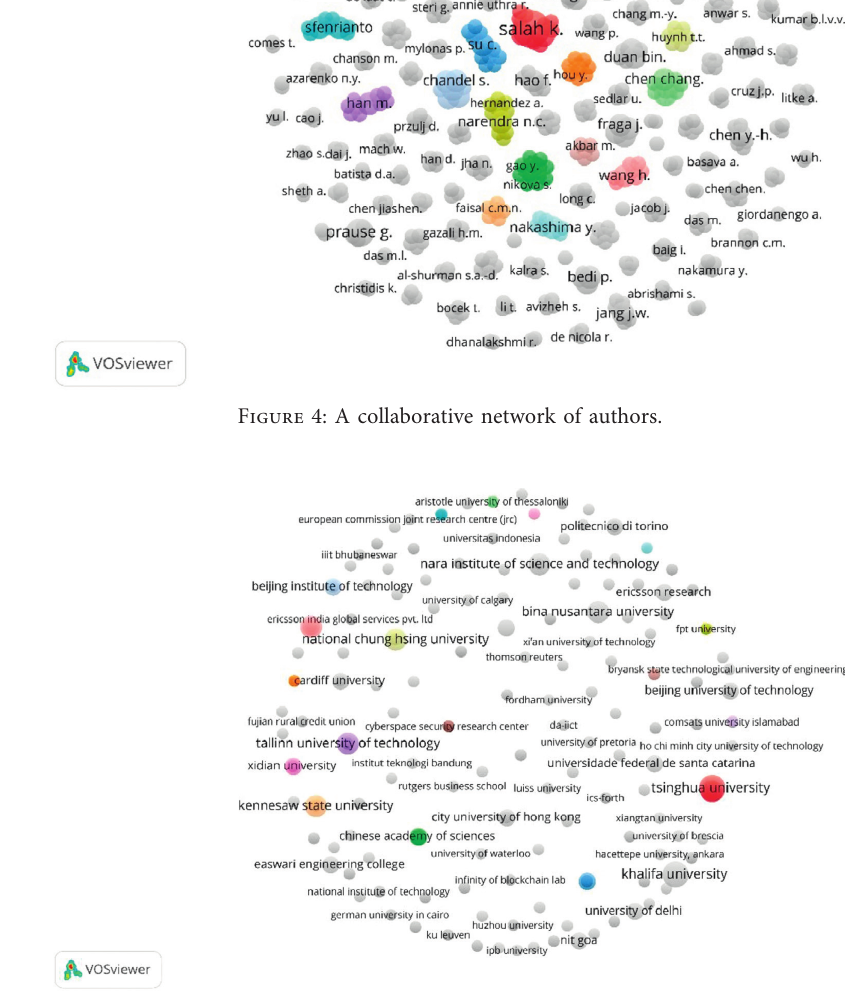
Figure 5: A network of cooperation between